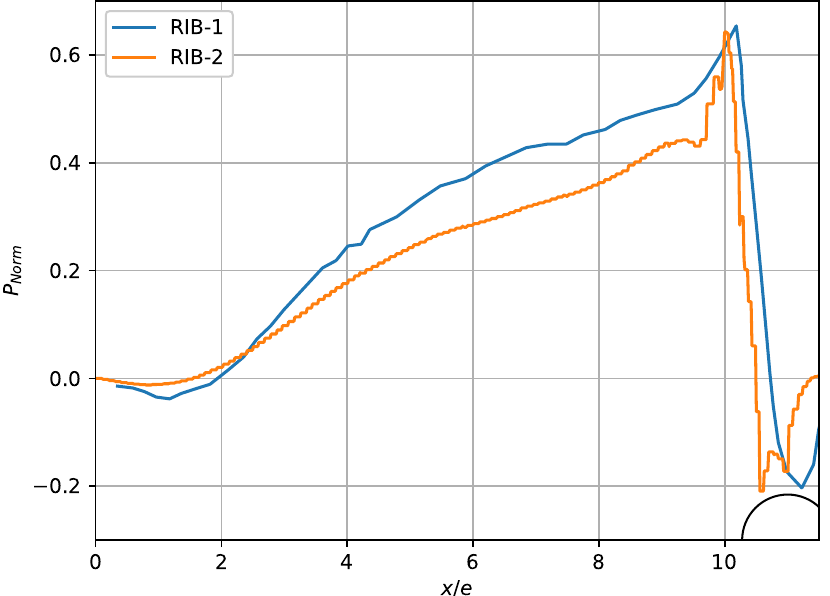
Figure 17. Comparison of the values of P Norm between RIB-1 with values from Campet et al. [19] and